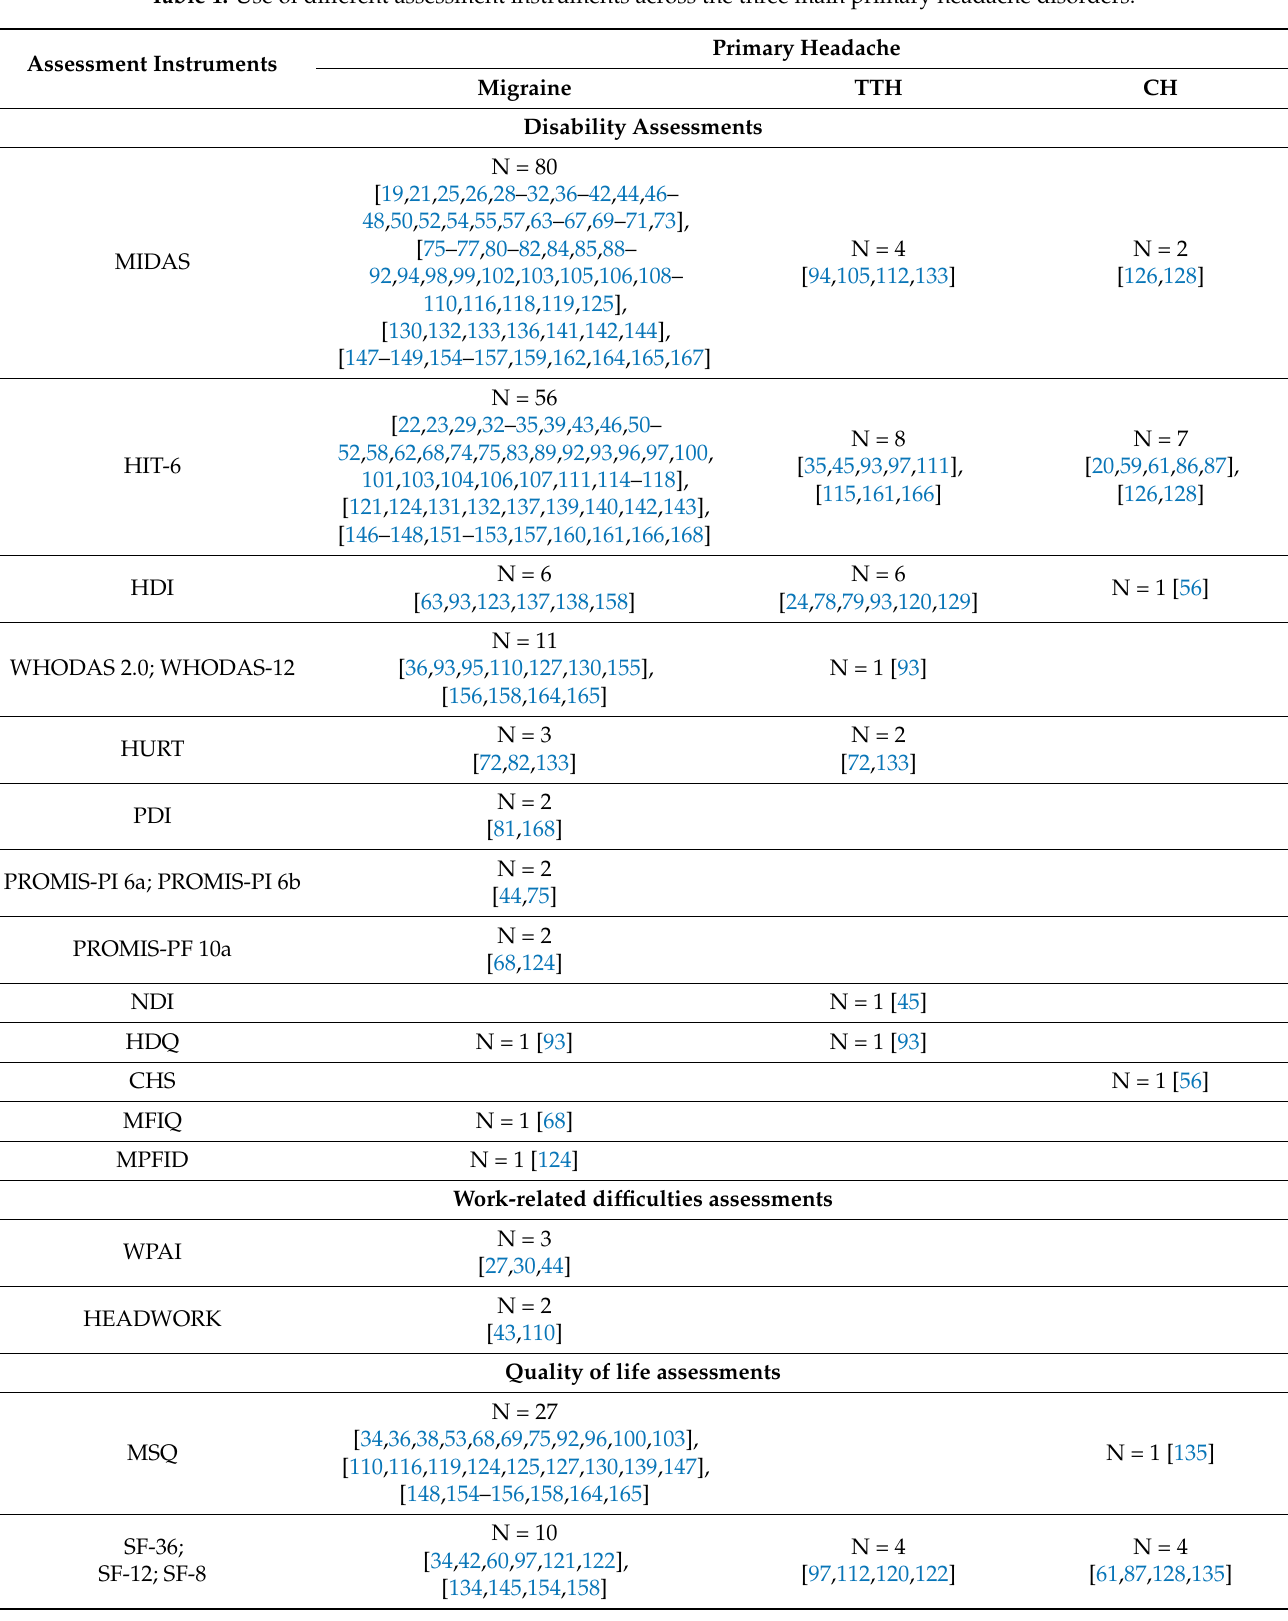
Table 1. Use of different assessment instruments across the three main primary headache